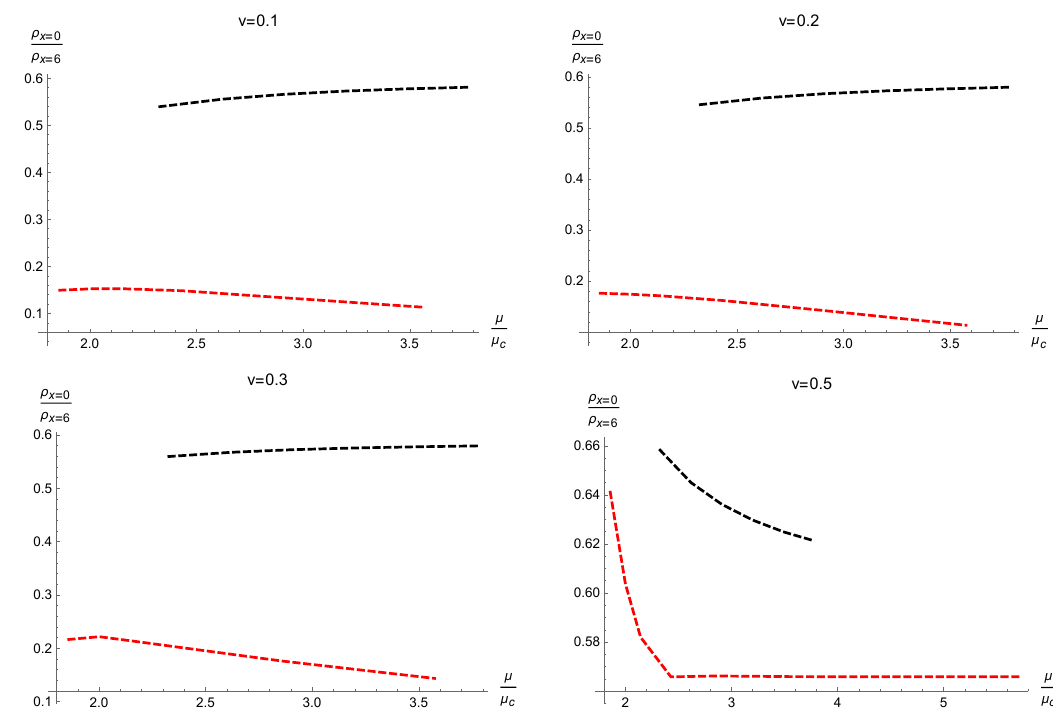
Figure 17 . The speci(cid:12)c values of density (cid:26) min respect to the relative chemical potential (cid:22)=(cid:22) c for the standard (black dashed) and alternative (red dashed)